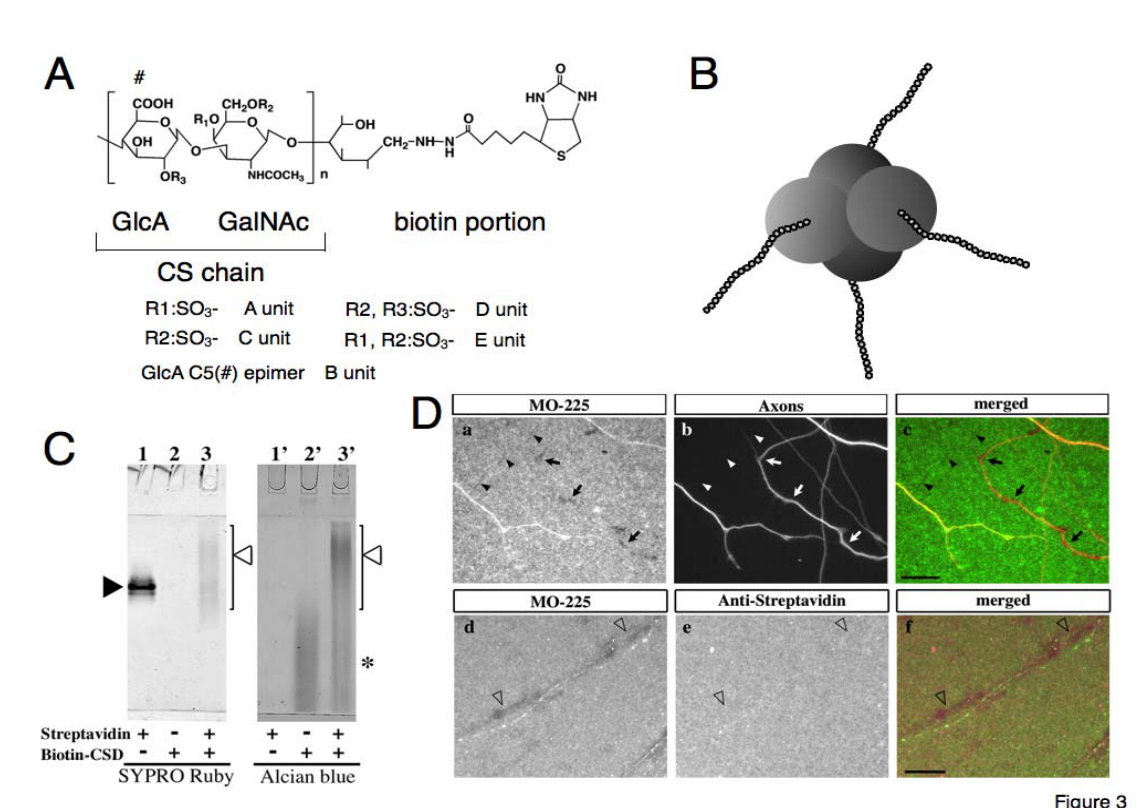
Figure 3. Schematic drawings of biotinylated chondroitin sulfate (CS-biotin) ( A ) and the CS-biotin-streptavidin complex ( B ). The reducing end of CS is coupled with biotin and the CS-biotin-streptavidin complex is formed with high affinity between biotin and streptavidin; it is thought that the complex consists of a tetramer. ( C ) Complex of CS-biotin and streptavidin in non-denaturing polyacrylamide gel double-stained with SYPRO Ruby (1-3) or Alcian blue (1’-3’). Samples loaded are shown below each lane: 1,1’ streptavidin; 2,2’ biotin-CS; 3,3’ mixed solution with CS-biotin and streptavidin. Open arrowheads: complex of CS-biotin and streptavidin; closed arrowhead: streptavidin; asterisk: unconjugated CS. ( D ) Streptavidin-biotin-CSD complex under the influence of retinal axons in vitro . ( a – c) Retinal culture on streptavidin-biotin-CSD complex substrate, Staining: ( a) MO-225, ( b) axons, c merged image. Arrows indicate absence of MO-225 staining under the axons, arrowheads indicate absence of MO-225 staining with no axons; the MO-225-negative areas are aligned like axon paths. ( d – f) After mechanical removal of axons. Staining: ( d ) MO-225 staining; ( e ) anti-streptavidin staining; ( f ) merged image. Open arrowheads indicate the absence of MO-225 staining and presence of anti-streptavidin staining along the axon paths. Bars 20 µm. ( C ) and ( D ) are adapted from Ando et al.